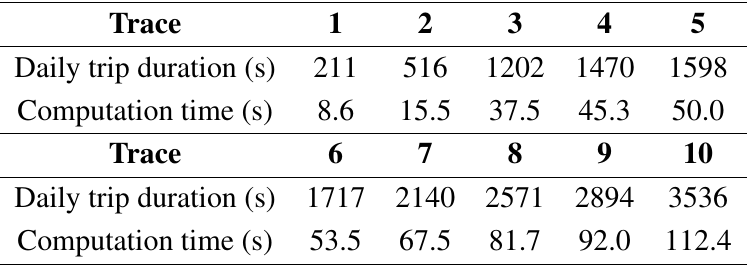
Table 1. Efficiency of 15-Year system lifetime